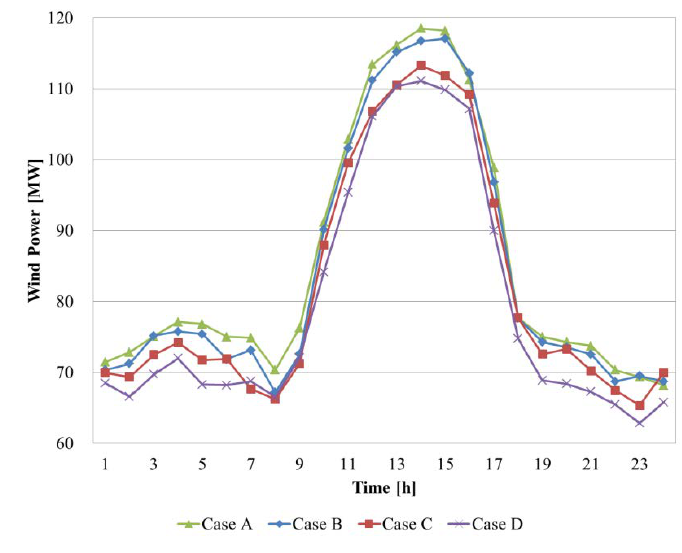
Figure 13. Wake effect on wind power